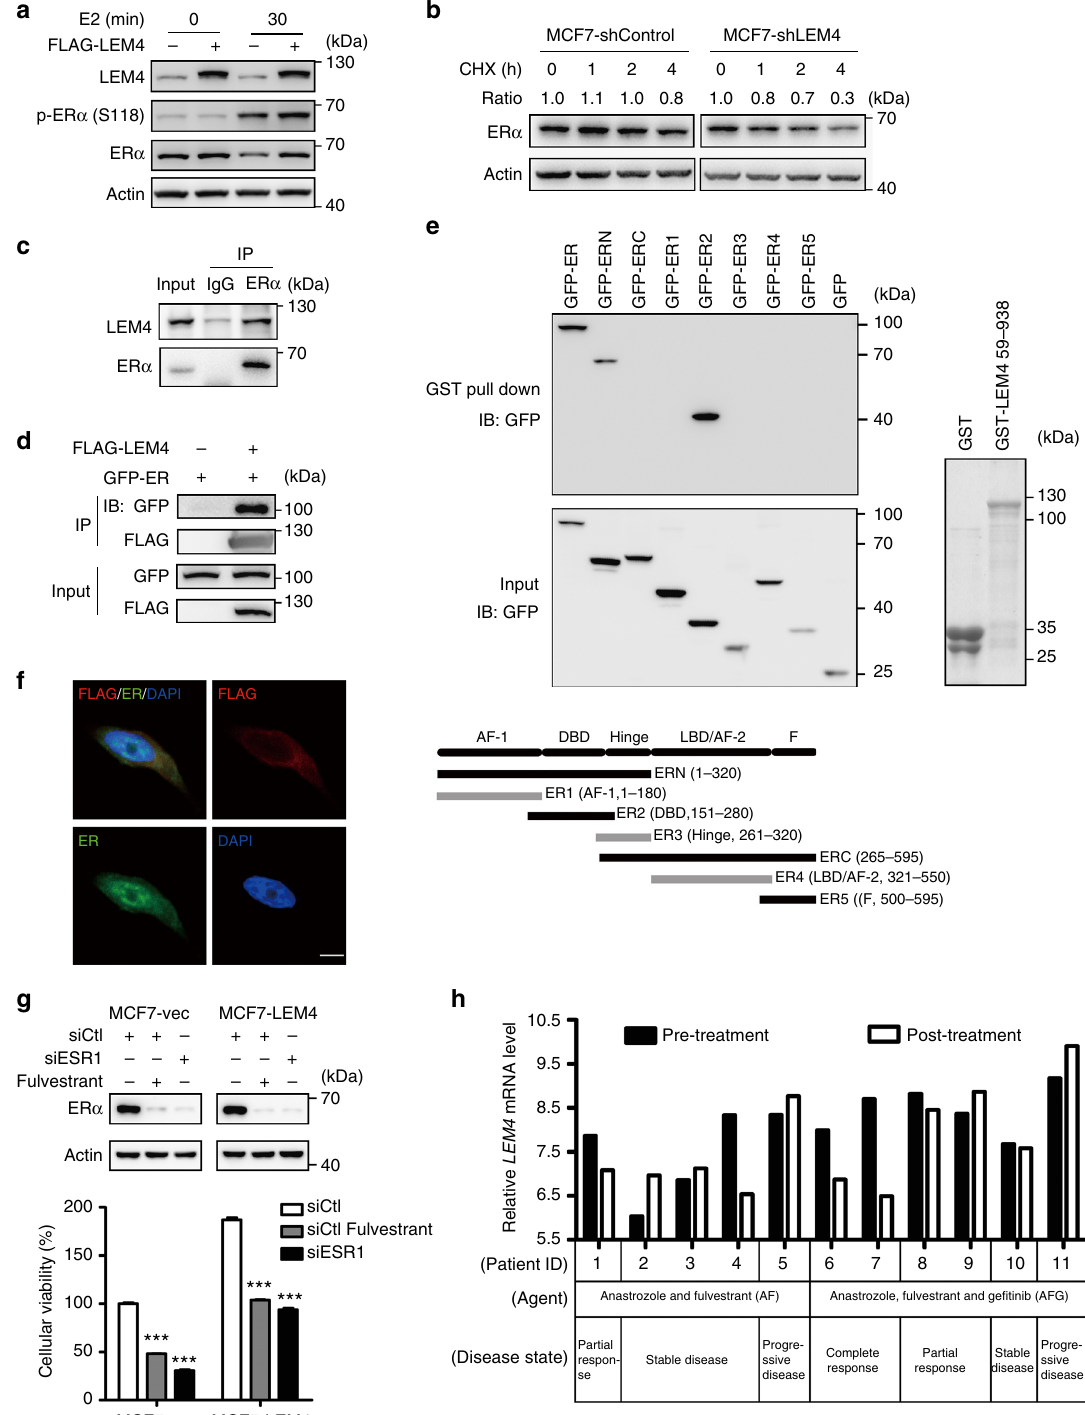
using median cutoff in each case. The study survival curves based on the LEM4 protein expression score in 284 patients were plotted using Kaplan – Meier analysis and the statistical parameters calculated by log – rank (Mantel – Cox) test using GraphPad Prism 6 software. Cell proliferation and viability assays . Cell proliferation was monitored by SRB assay and EdU (5-ethynyl-2 ′ -deoxyuridine) incorporation assay. The SRB assay was performed following an already established procedure 59 . Brie fl y, cells were plated into 24-well plates, followed by incubation of cells with treatment